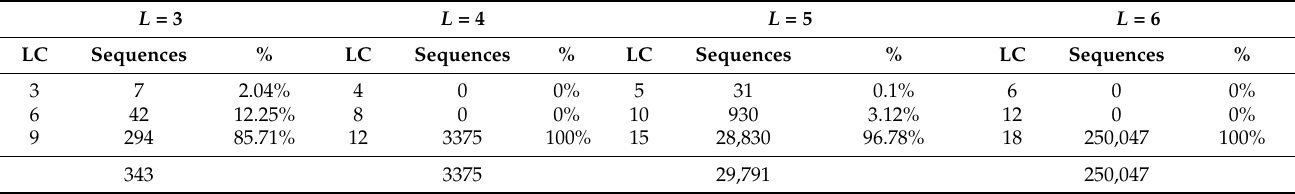
Table A1. Number and percentage of 3-interleaving sequences, with different values of LC , formed by PN-sequences with characteristic polynomials of degree L = 3,4,5,6.